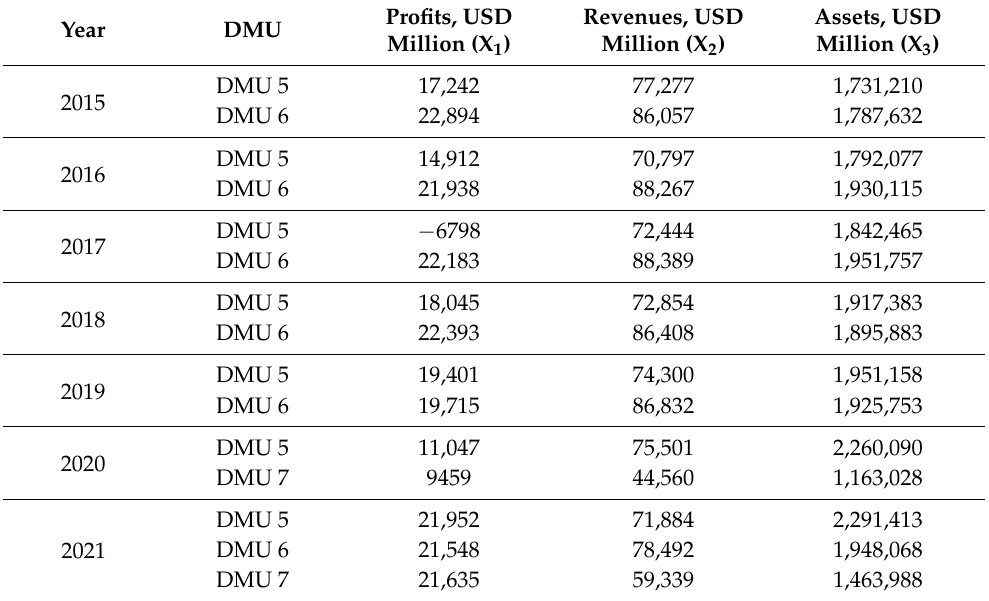
Table A1. Data for cluster 1 for regression analysis